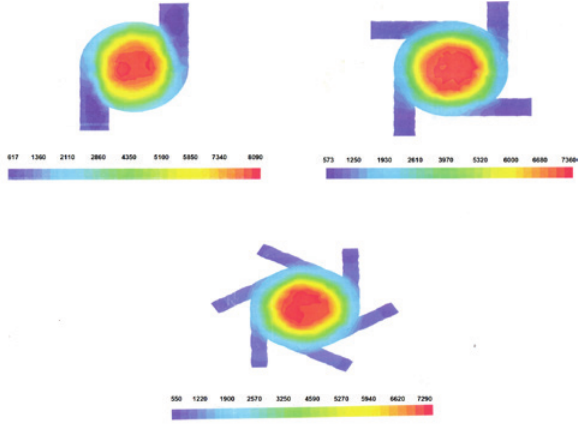
Figure 11. The turbulence kinetic energy for vortex tubes with two, four and six inlet nozzles